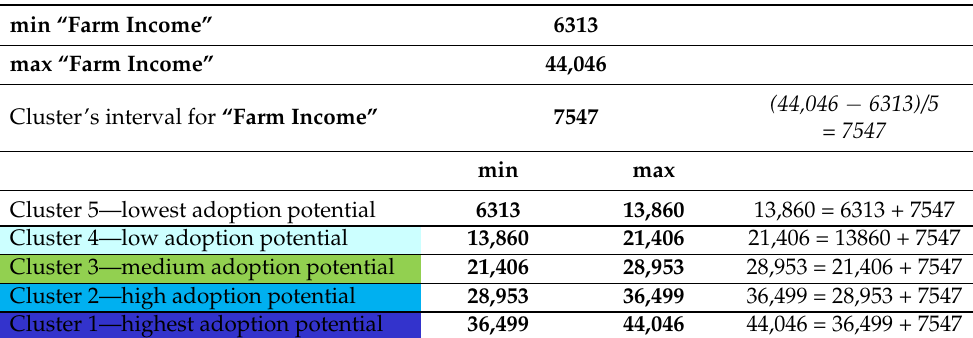
Table 8. Calculations for the “cluster interval” for variable “Farm Income” (Gross value added per employed person in agriculture, forestry and fishing) .